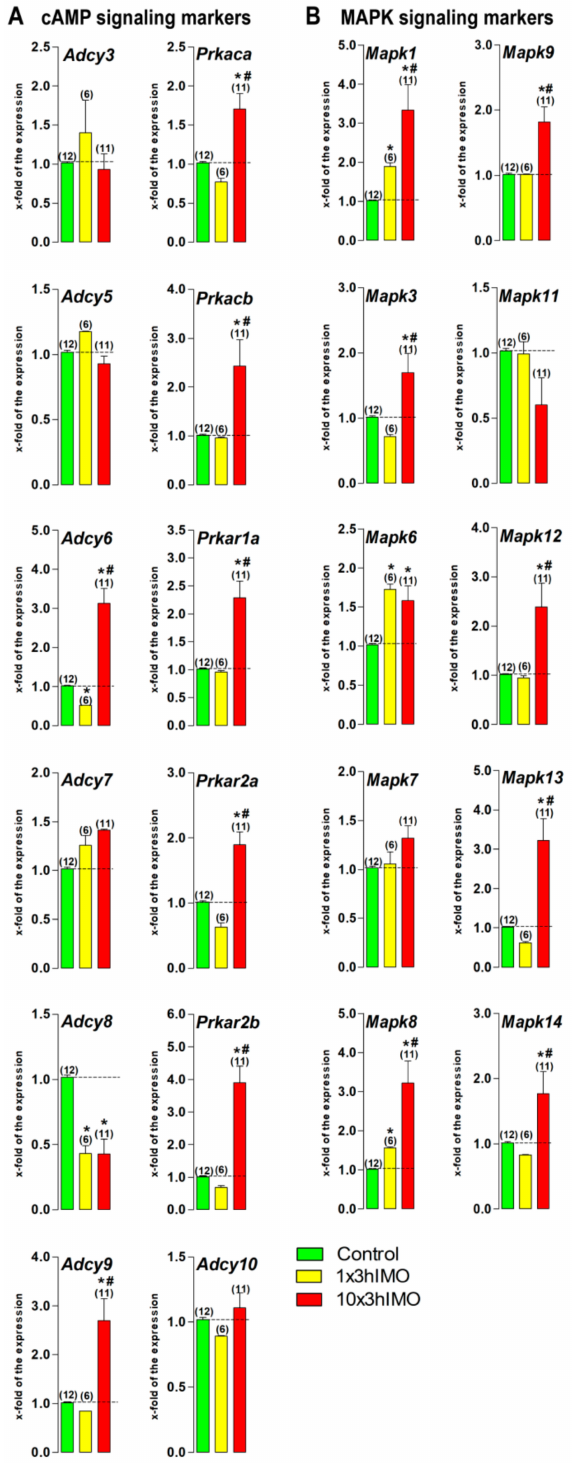
Figure 3. The transcriptional profiles of signaling molecules regulating mitochondrial dynamics and functionality as well as spermatozoa number and functionality are changed in spermatozoa of repeatedly stressed adult rats. RNA isolated from spermatozoa obtained from undisturbed and stressed rats were used for analysis of the transcriptional profile of markers of cAMP signaling ( A ) and MAPK signaling ( B ) pathways. Data bars are mean ± SEM values of three independent in vivo experiments. Statistical significance was set at level p < 0.05: * vs. control group; # vs. 1 × 3hIMO